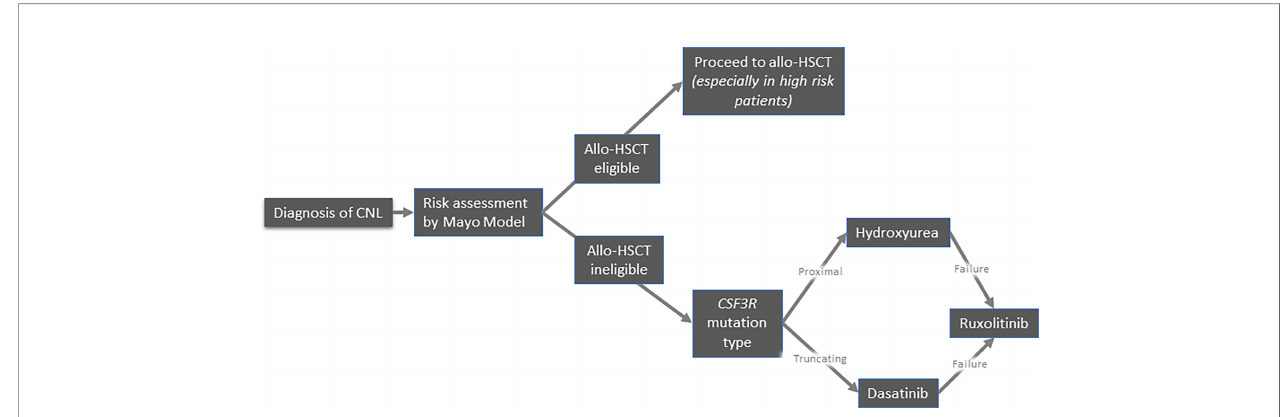
FIGURE 4 | Suggested algorithm for treatment of patients with chronic neutrophilic